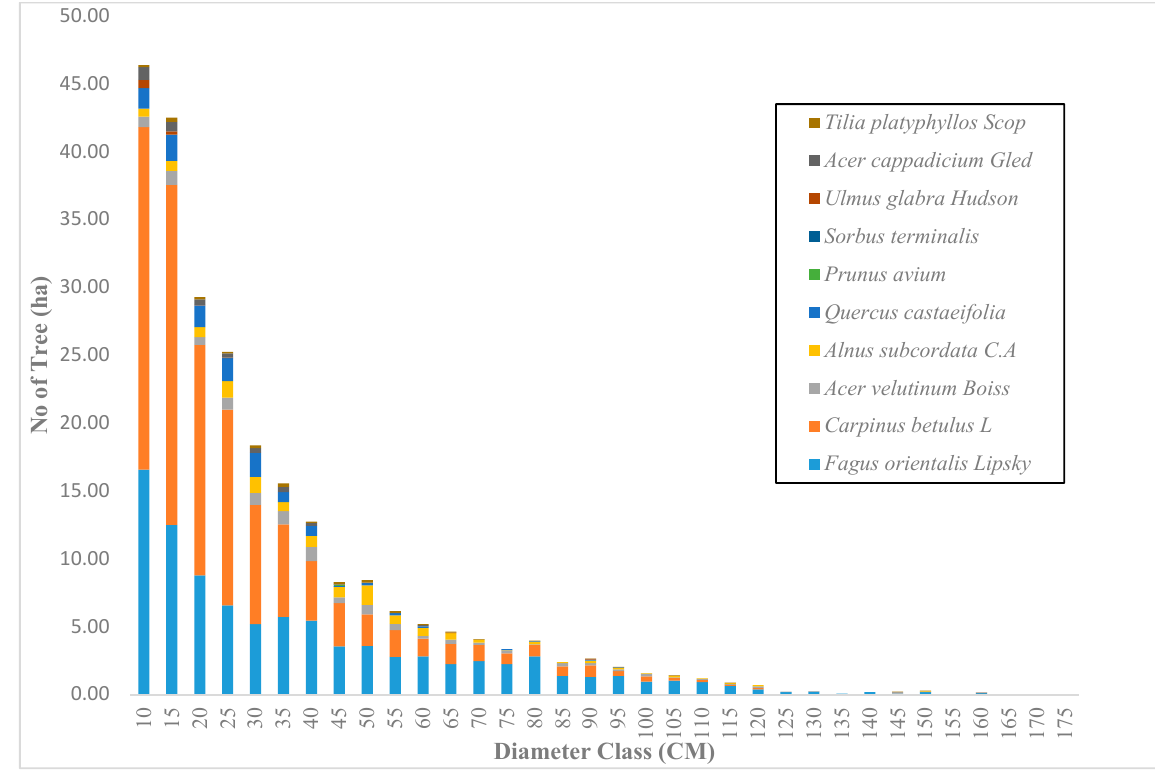
Figure 4. The diameter distribution for uneven-aged and mixed forests in the Gorazbon section in year 2003.